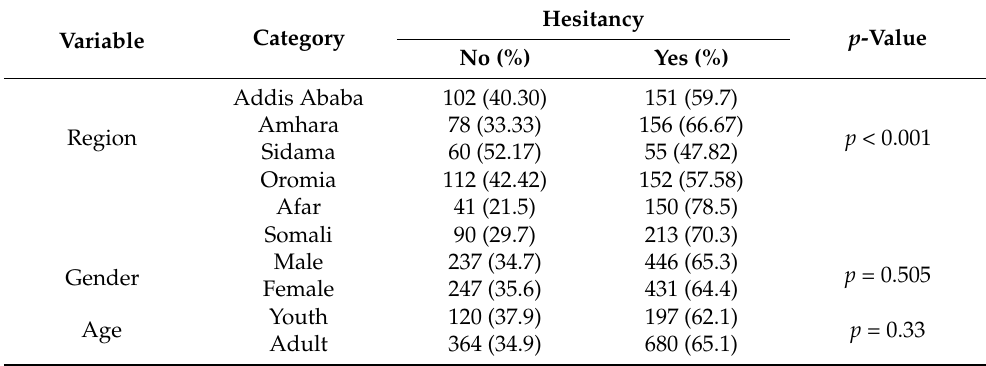
Table 8. Vaccine hesitancy by region, sex, and age of respondents at the time of the vaccine hesitancy survey in Ethiopia, 2022.